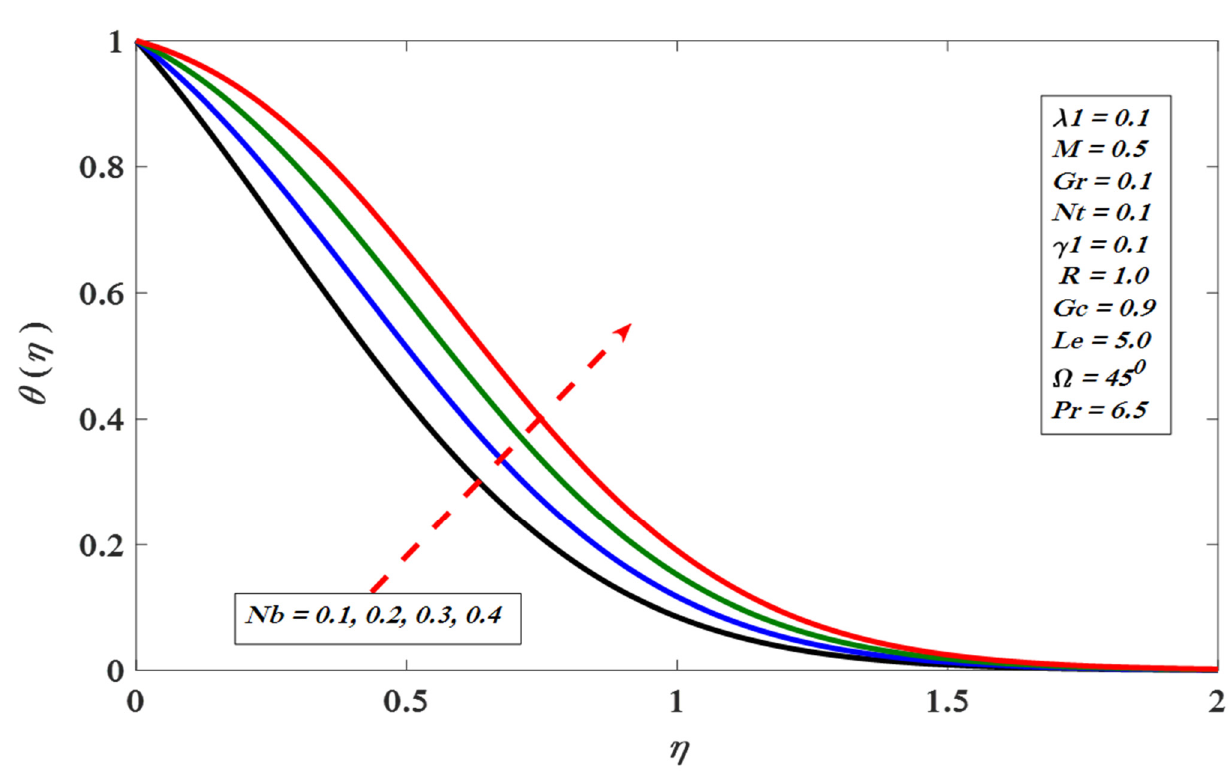
Figure 10. Temperature profile versus Nb .